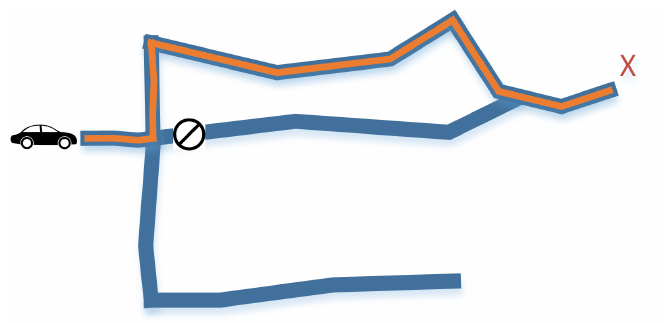
Figure 10. Rerouting due to a full road